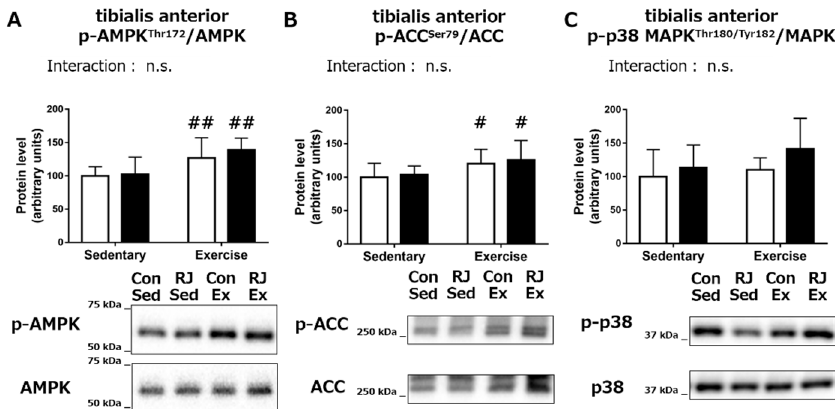
Figure 5. ( A ) AMPK, ( B ) ACC, and ( C ) p38 MAPK phosphorylation status in tibialis anterior muscle of mice that treated with a single dose of royal jelly (RJ-treated group; black) or distilled water (Control group; white) and with or without an endurance exercise (Acute experiment). Values represent mean ± standard error. n = 6–7 per group. # p < 0.05 and ## p < 0.01, main effect of endurance exercise. n.s.: not significant.